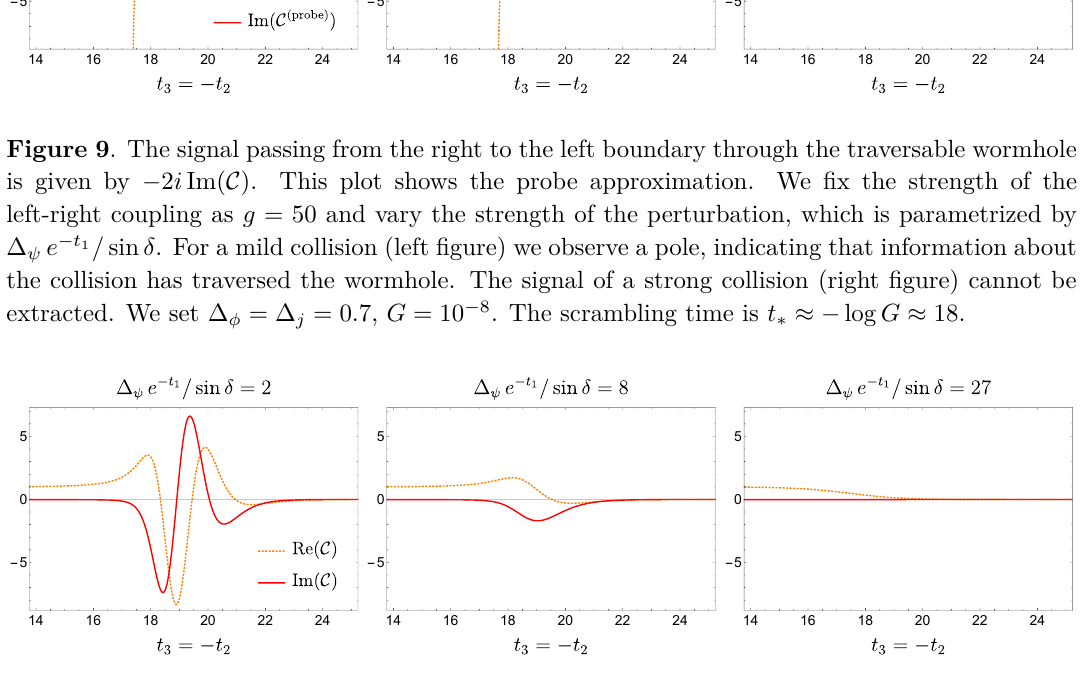
Figure 10 . The numerical results for C from (4.9) with the same setup as shown for the probe limit in figure 9. The strength of the perturbation is parametrized by ∆ perturbation (left figure) the negative energy is enough to make the wormhole traversable and we obtain a clear signal from the collision. In case of a strong collision (right figure) the ‘teleportation operator’ is not strong enough to extract a signal. Parameters: g = 50 , ∆